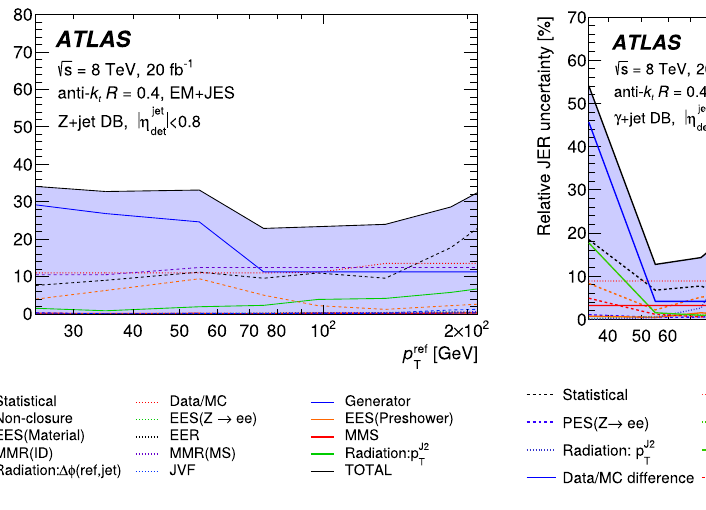
Fig. 36 Summary of systematic uncertainties of the JER measured using the DB method in a Z +jet and b γ +jet events for anti- k t jets with R = 0 . 4 calibrated with the EM+JES scheme. The difference between the JER measured in data and MC simulation is presented as an uncertainty (“data/MC difference”). The total uncertainty, shown as